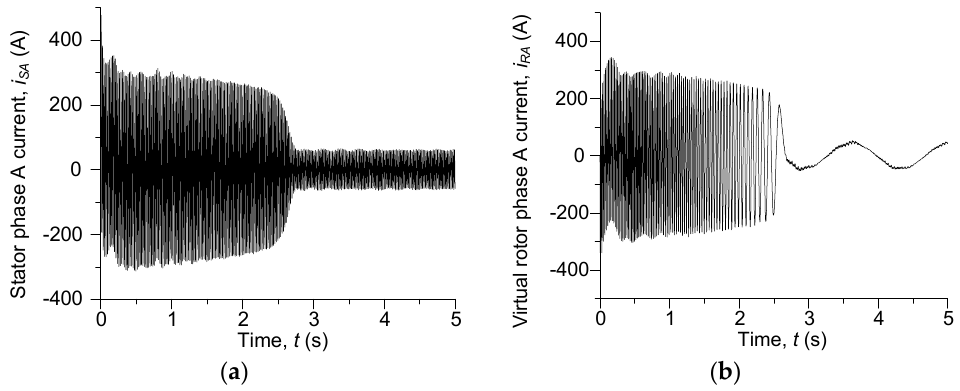
Figure 16. Current waveforms for D = 0.1825 m, α 1,2 = α 2,3 = π /5 and: ( a ) stator phase A current; ( b ) rotor’s virtual A phase currents.